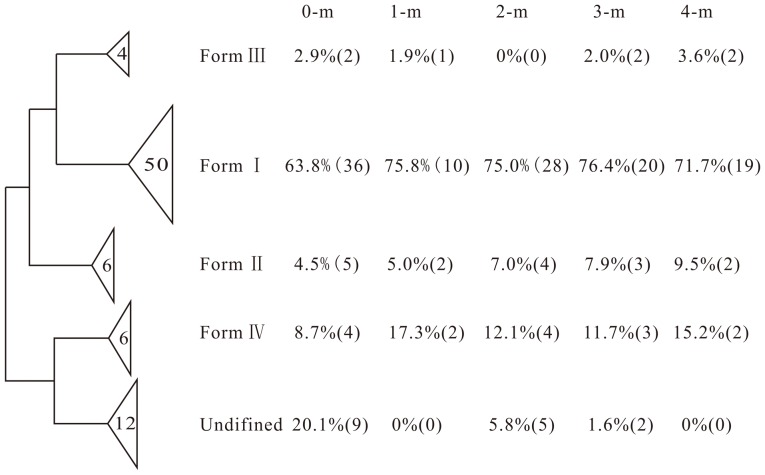
The distribution of rbcL genes.The width of each wedge is the number of rbcL sequences within each cluster. The percentages and numbers in each bracket are the signal proportions and detected gene numbers of each cluster within each depth, respectively.